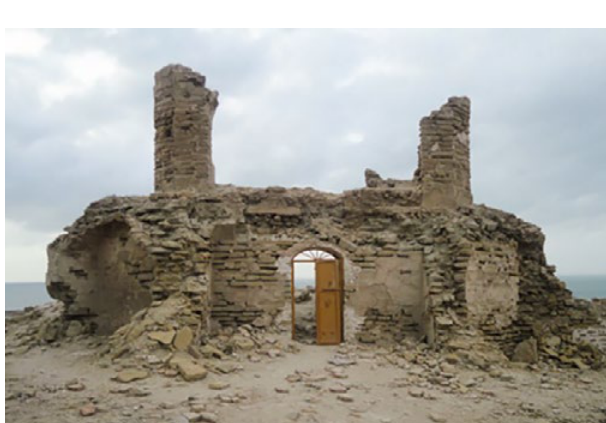
Fig. 2. Lipar Pink Lake Fig. 2: Lipar Pink Lake